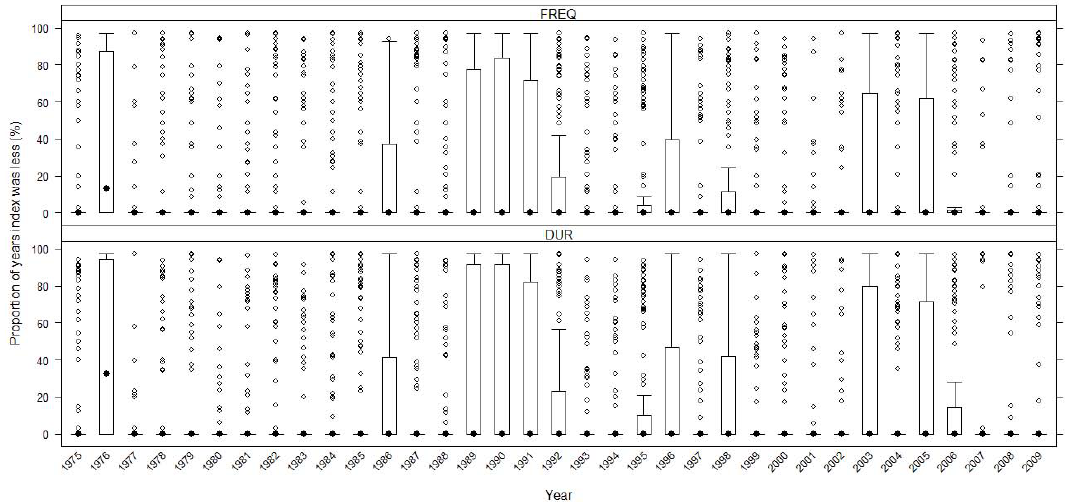
Fig. 4. Box plots of the annual variables (FREQ and DUR) for all years. The plots show data for only the gauging stations on intermittent segments. The variables have been standardized within stations by expressing them as the frequency that the index was less. Plotted values therefore indicate the severity of the zero-flow events in each year relative to the extremes observed at each station. The box contains the inter-quartile range, the dot shows the median value, whiskers indicate 1.5 times interquartile range and the circles indicate